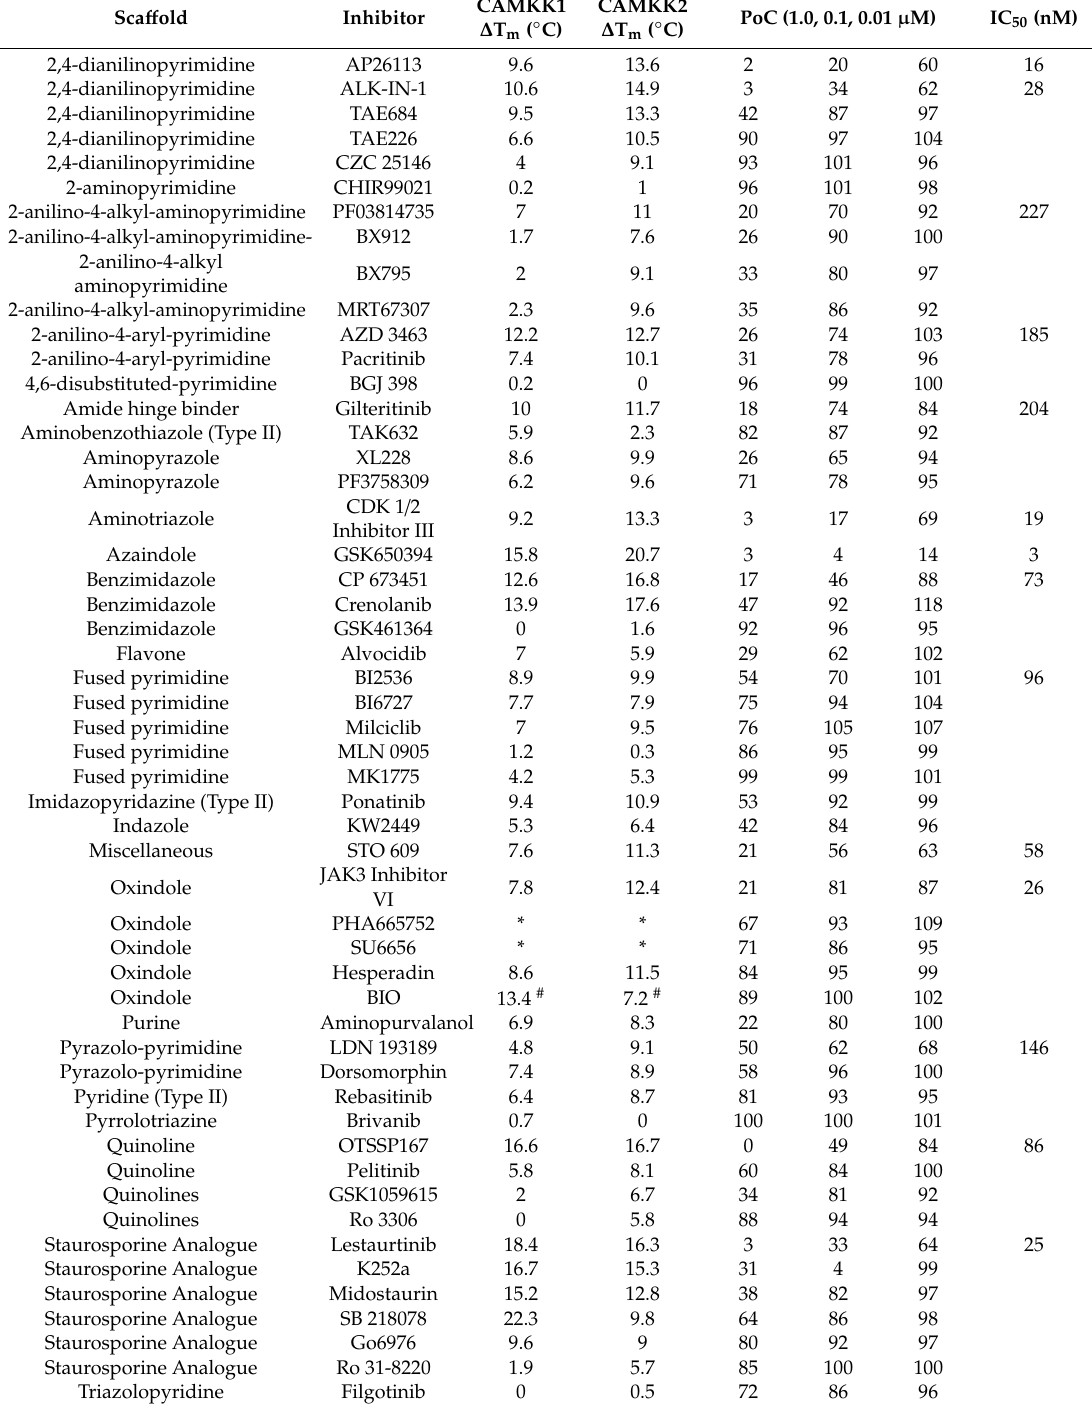
Table 1. The inhibitors acquired and tested and their sca ff old types. DSF results are a mean of n = 3 runs. IC 50 values were generated in an 8-point full dose response assay. (* Assay interference; # n = 1). Sca ff old Inhibitor